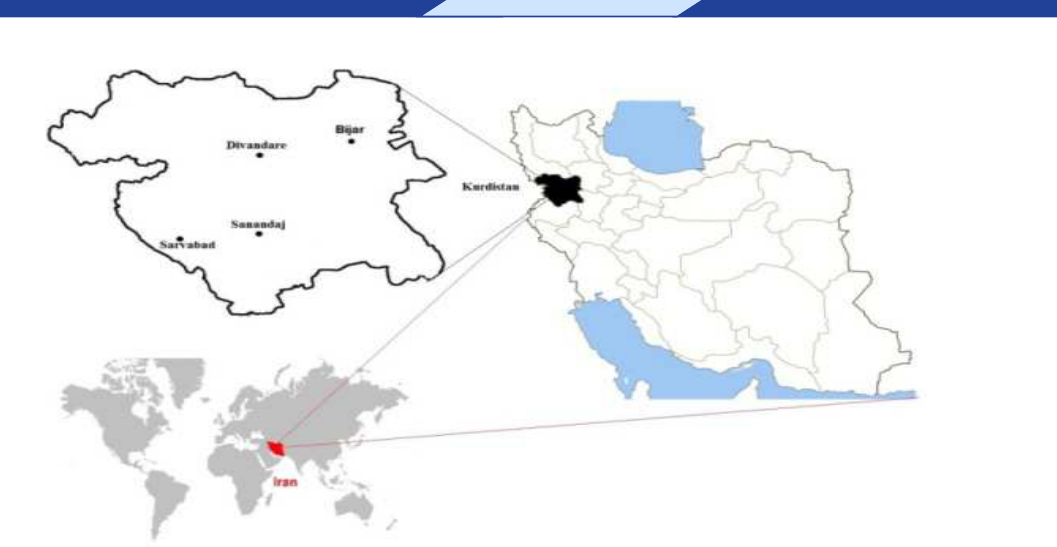
Figure 2. Study area (Kurdistan province,